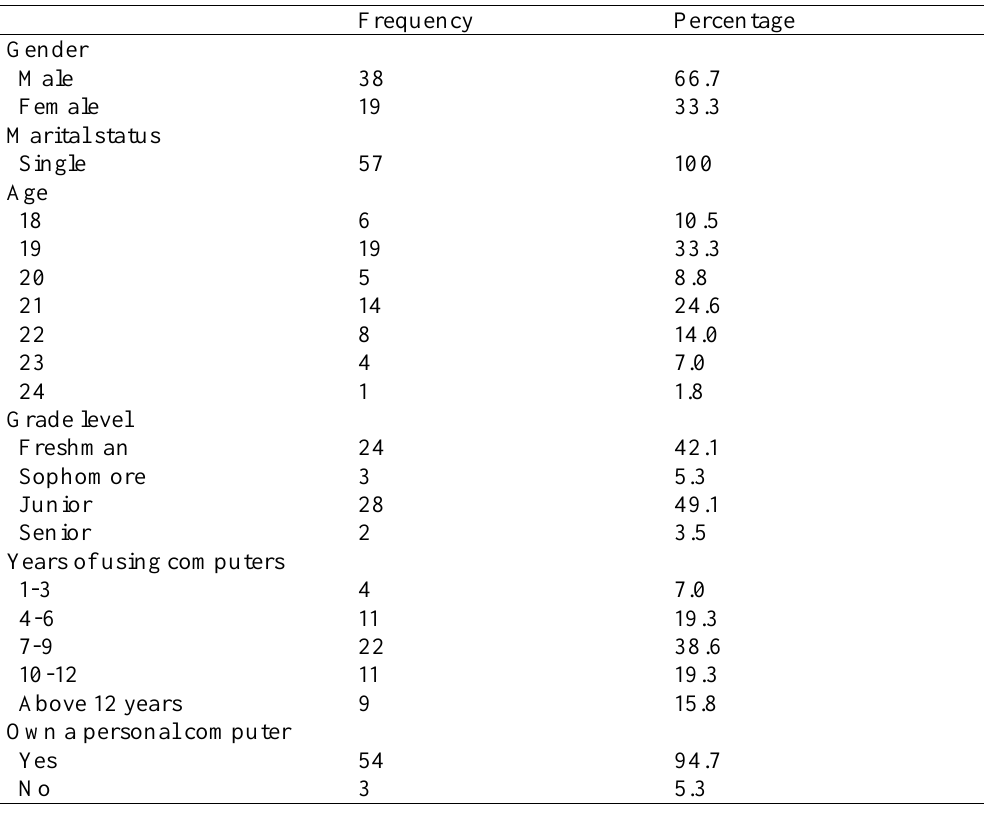
Student Demographic